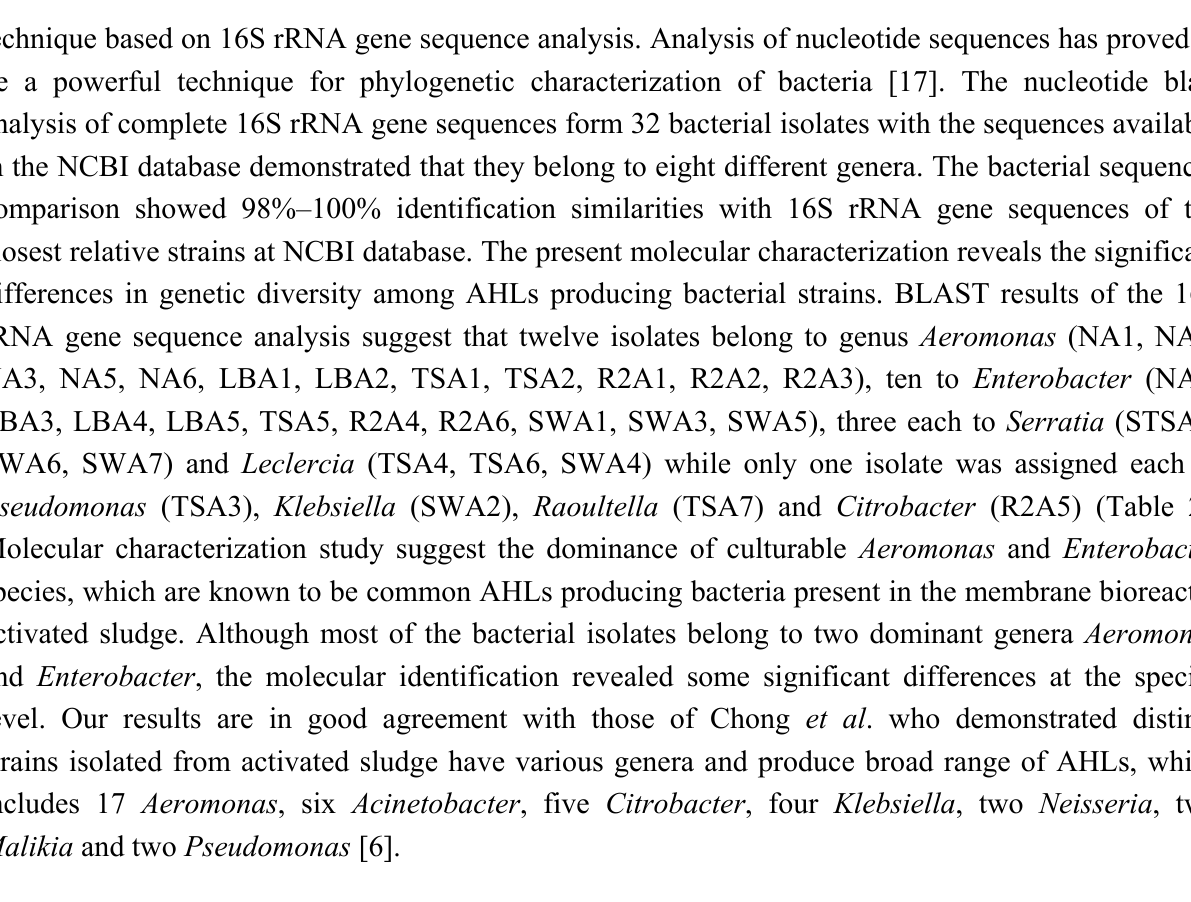
Table 2. Nucleotide blast analysis of 16S rRNA gene sequences from AHLs producing bacterial isolates using BLASTN